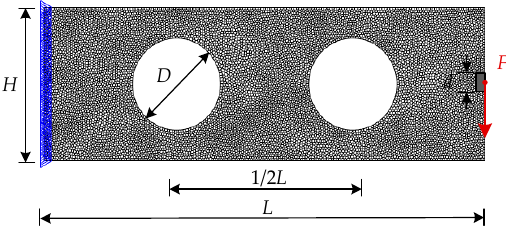
Figure 15. Design domain and boundary conditions for a rectangular plate with circular holes.